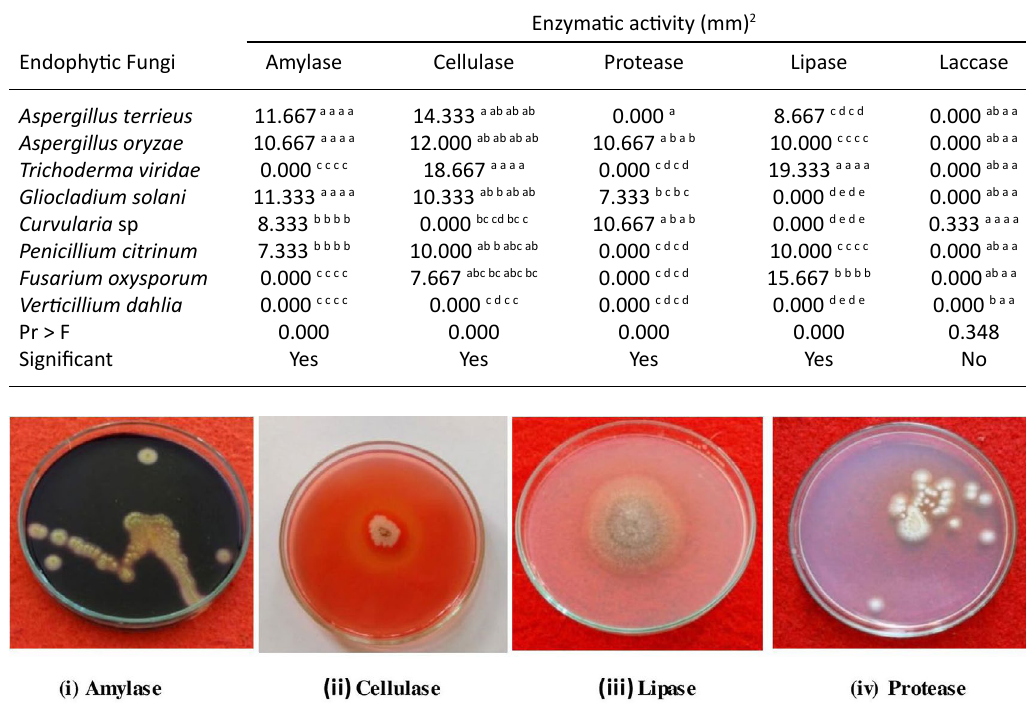
Fig. 4. Screening of endophytic fungi for enzyme production.